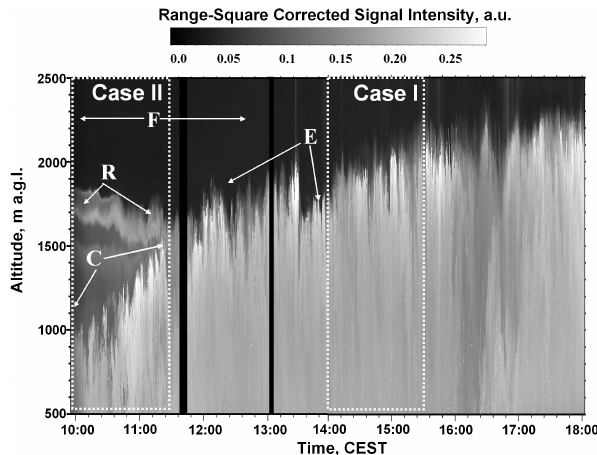
Fig. 2. Time-height cross-section of the range-square-corrected backscatter signal measured on 26 June 2004 from 09:55 to 18:10CEST. Dotted boxes are the selected regions of Case I and Case II. Temporal and spatial resolutions are 0.033s and 3m, re- spectively. R: a strong residual layer from previous day showed up around 1.8km a.g.l., F: free atmospheric air with very low aerosol load above 2.0km a.g.l., C: CBL growth during morning eroded the nighttime stable residual layer, E: entrainment at the top of the CBL. Black stripes mark two gaps where no data are